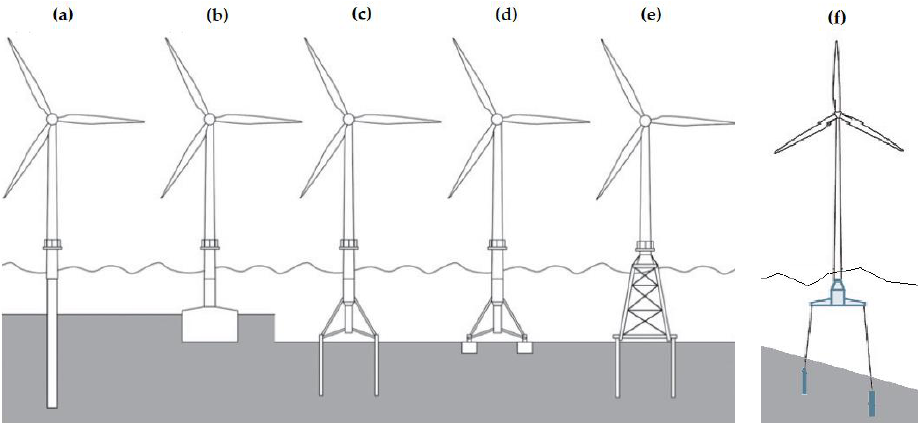
Figure 1. Common foundation types used in offshore wind turbine design: mono-pile ( a ), caisson foundation ( b ), multi-pile foundation ( c ), multi-pod suction bucket ( d ), jacket ( e ) and floating foundation ( f ) [4].